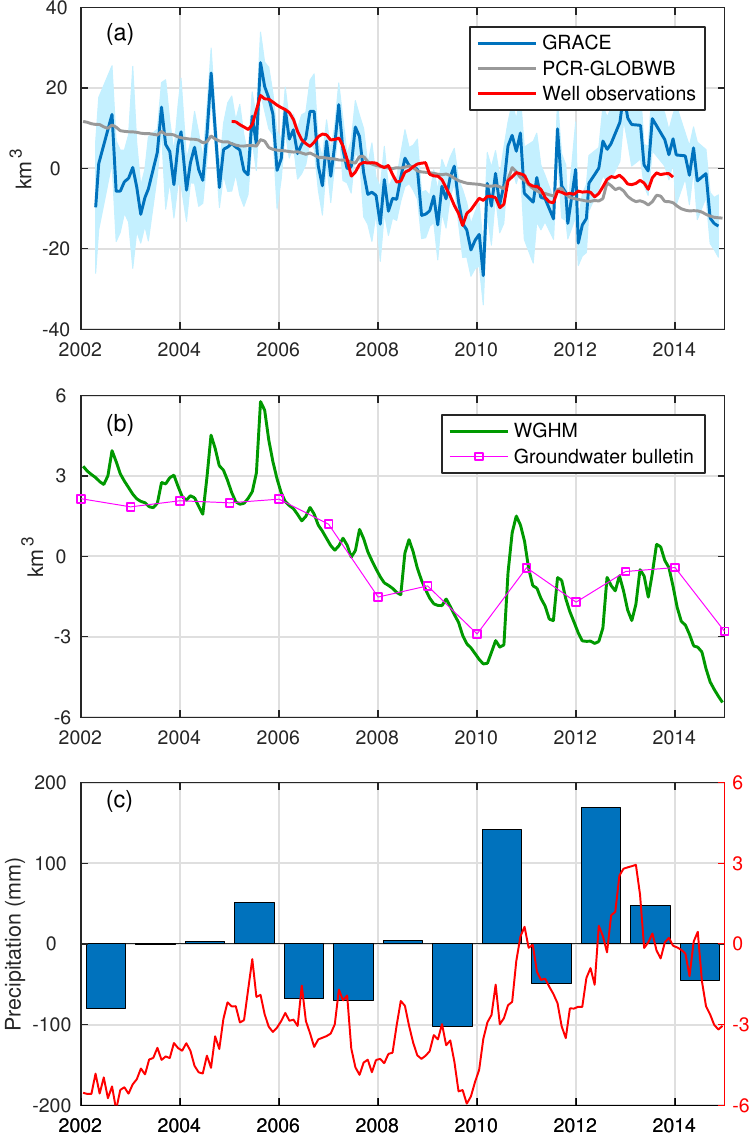
Figure 7. ( a ) Time series of GWS changes in the LRB from GRACE, PCR-GLOBWB and well observations from 2002 to 2014. Shaded areas are estimated uncertainties in GRACE-derived GWS changes; ( b ) Same as ( a ), but from WGHM and groundwater bulletins; ( c ) Annual precipitation anomalies and PDSI values in the LRB from 2002 to 2014. Table 1. GWS rates (km 3 /yr) in the LRB based on GRACE, well observations, HMs and